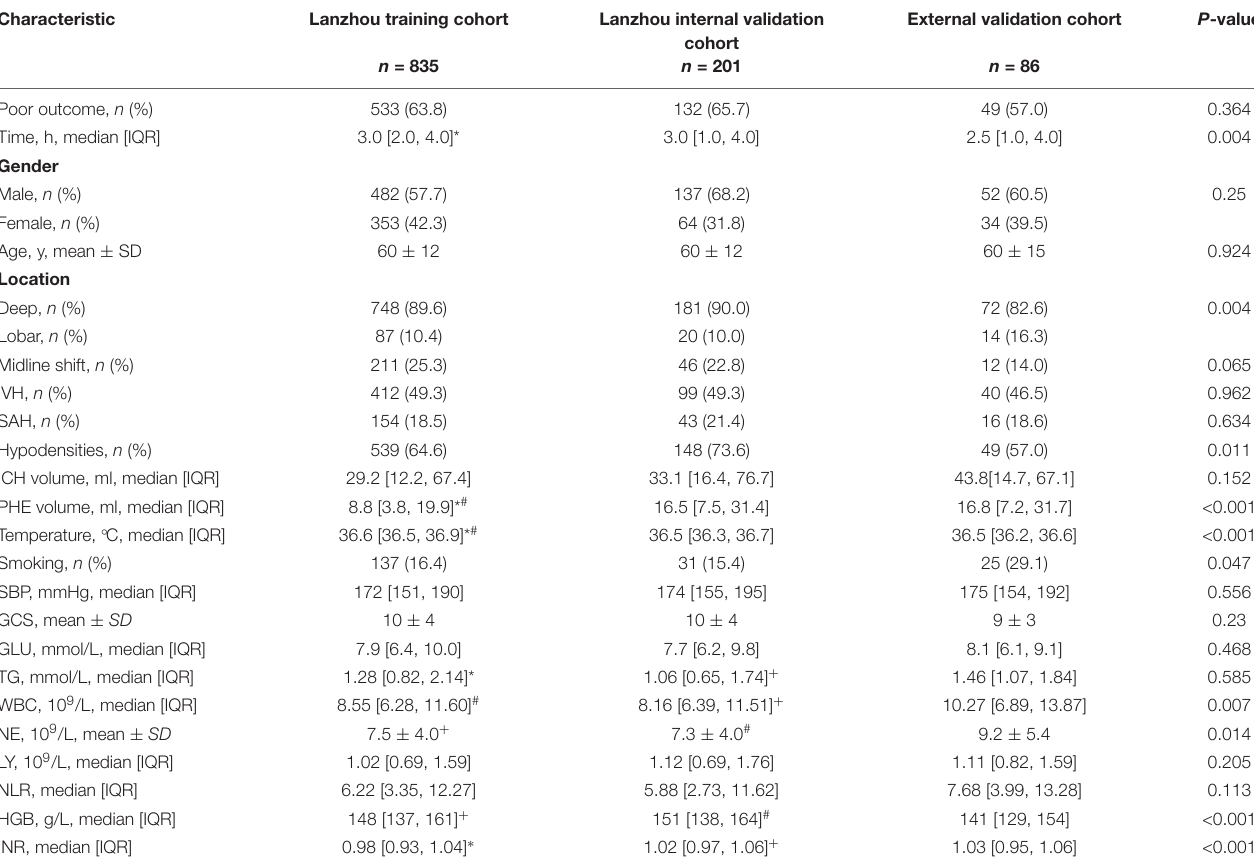
TABLE 1 | Patients’ characteristics in the training or validation cohort.